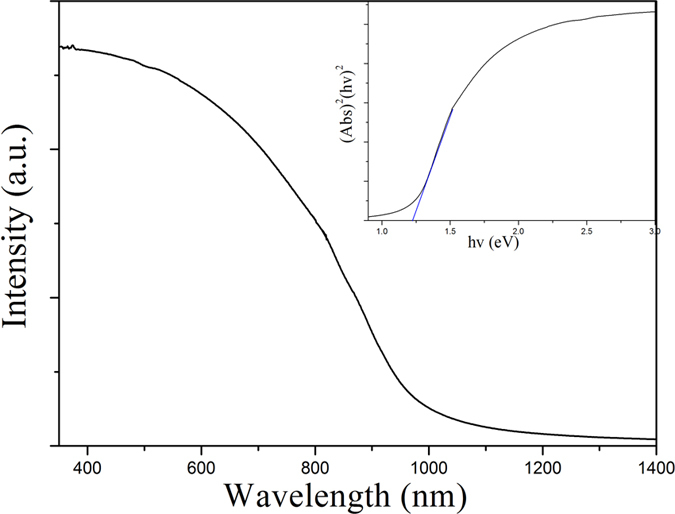
UV-Vis diffuse reflectance spectrum of Bi2S3 nanocrystals prepared at 180 °C for 12 h.